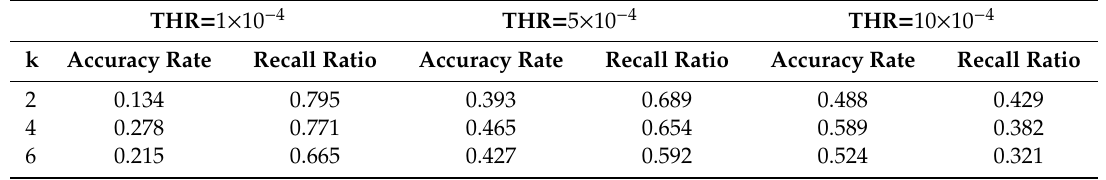
Table 2. Detection results based on connected nodes method under different settings.